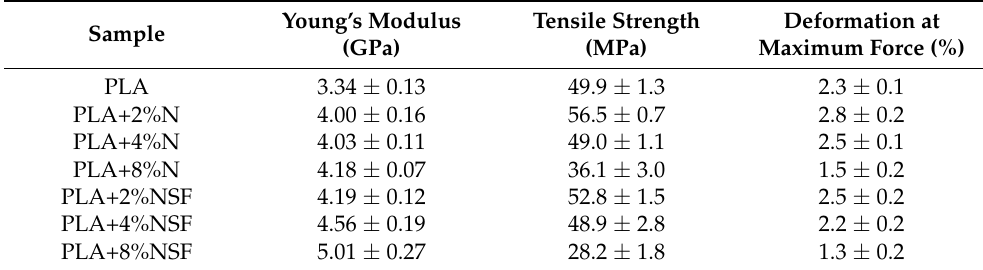
Table 3. Mechanical properties of PLA and PLA